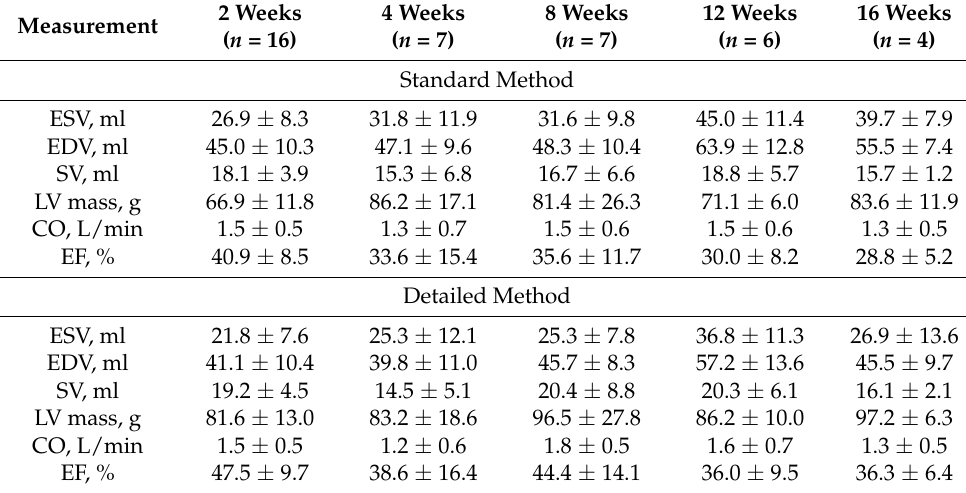
Table 3. Volumetric measurements of the infarcted hearts of Yucatan minipigs at the different time points after MI using the standard and detailed methods.